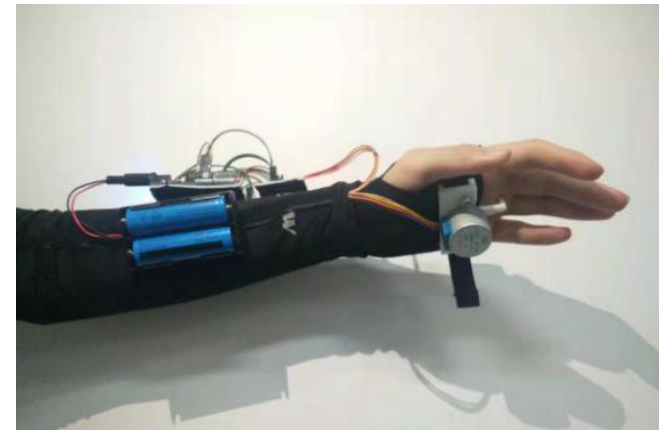
Figure 7. Proof of concept prototype of guidance glove [53].